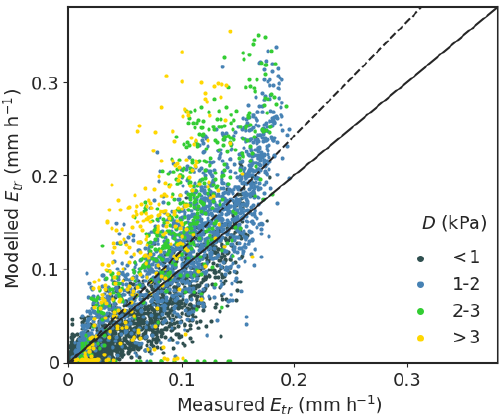
Figure 11. Modelled hourly E tr compared with measured hourly E tr over 2013. The solid line represents the 1 : 1 line. The dashed line is the linear fit between modelled and measured E tr . Colours of dots indicate the range of vapour pressure